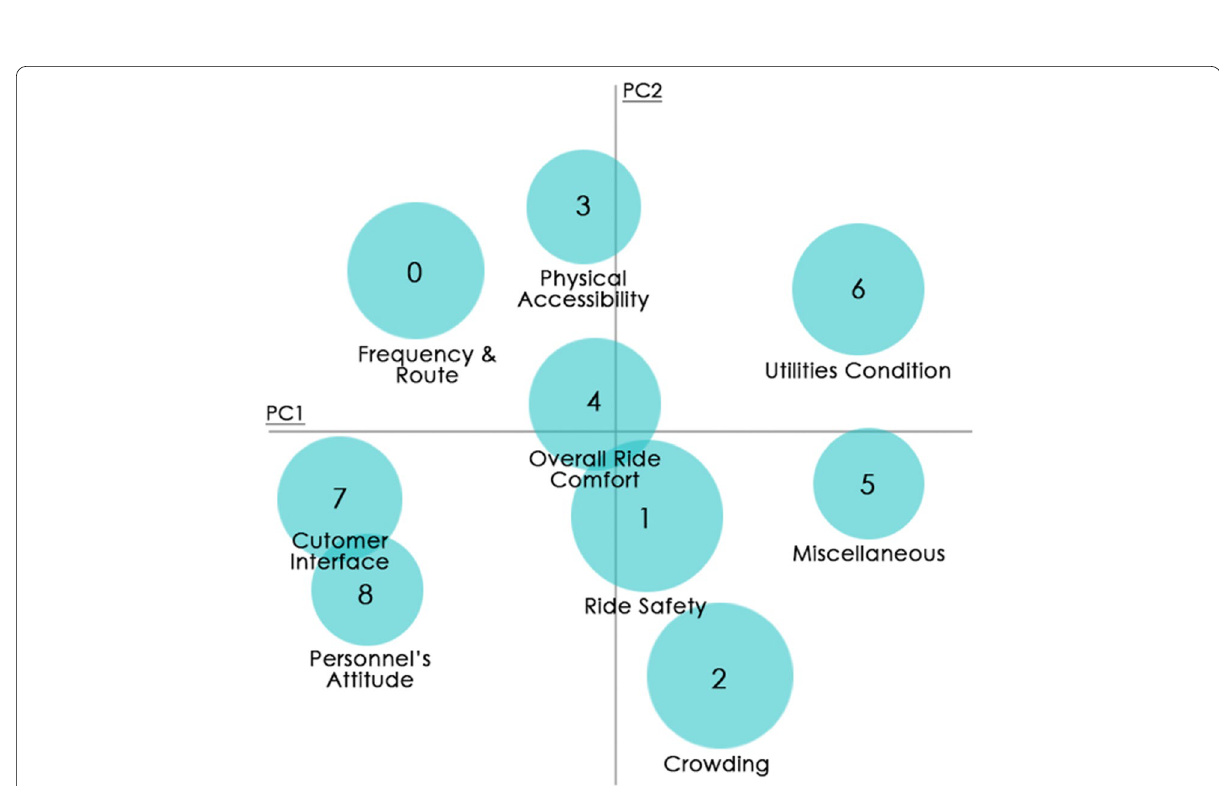
Fig. 4 Inter-topic distance map. Source: